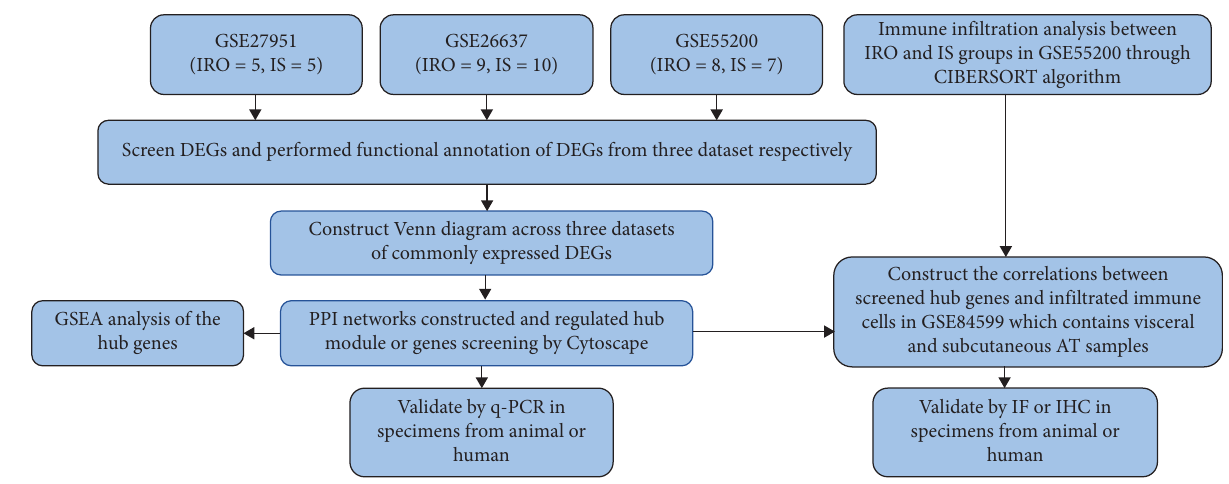
Figure 1: Workflow of our whole study